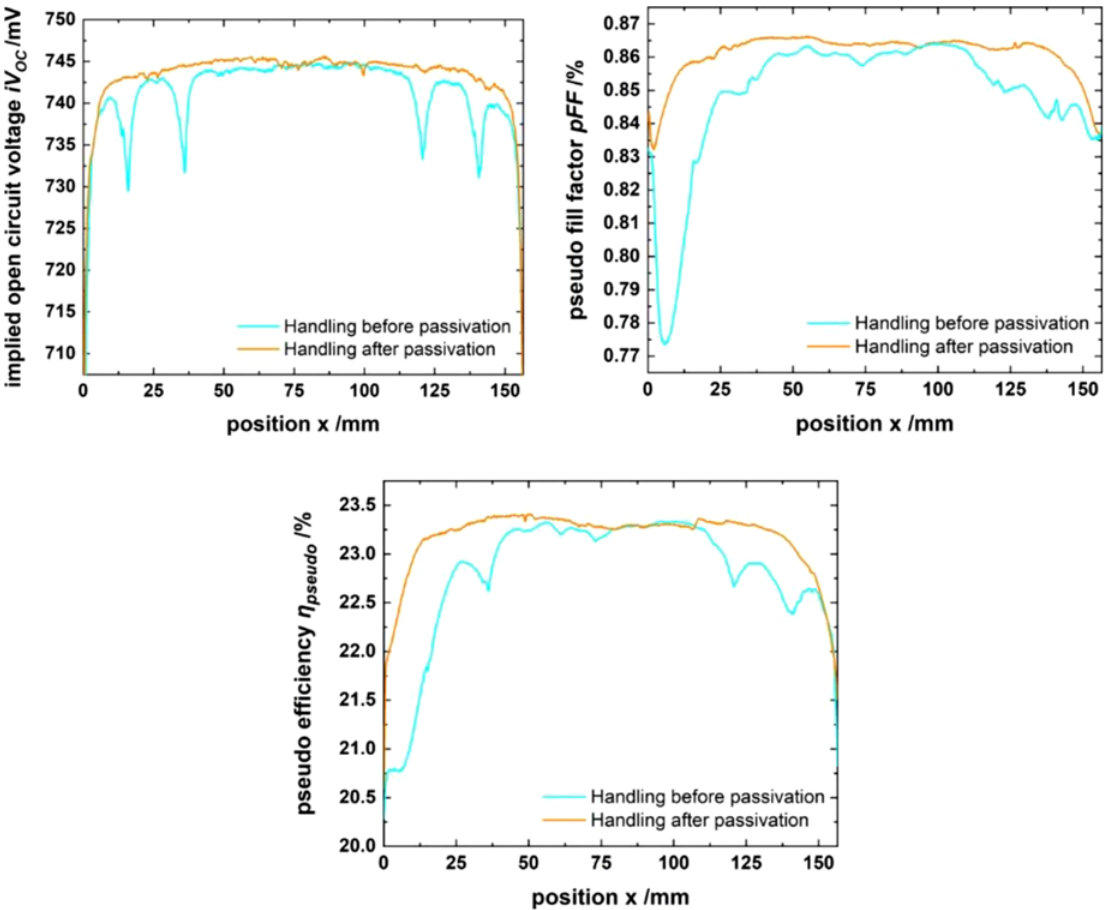
Fig. 4. Line plots of averaged images for h pseudo (bottom), iV OC (top left) and pFF (top right) handled before (blue) or after passivation